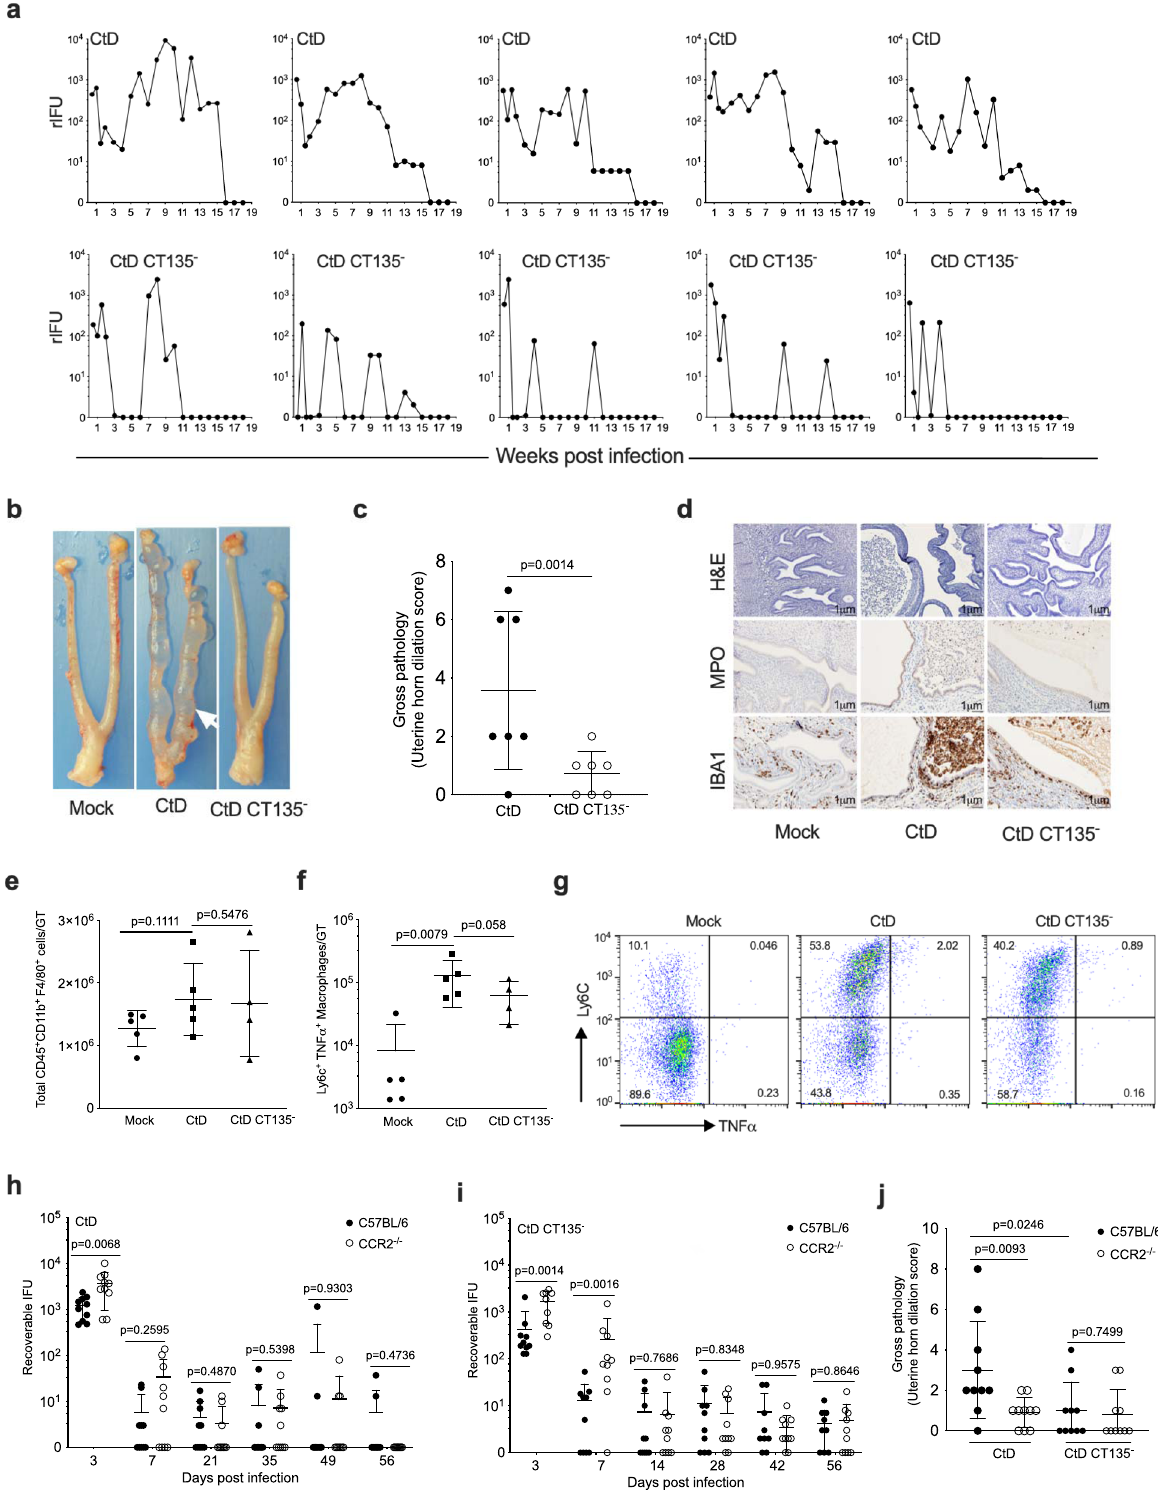
mice differed between CtD and CT135 − , total leukocytes were isolated from the entire GT and CD11b + F4/80 + macrophages were quantitated by fl ow cytometry. We found total CD11b + F4/ 80 + macrophages were signi fi cantly higher in CtD and CtD CT135 - infected mice compared to mock infection but did not differ between the two groups of infected mice. We next